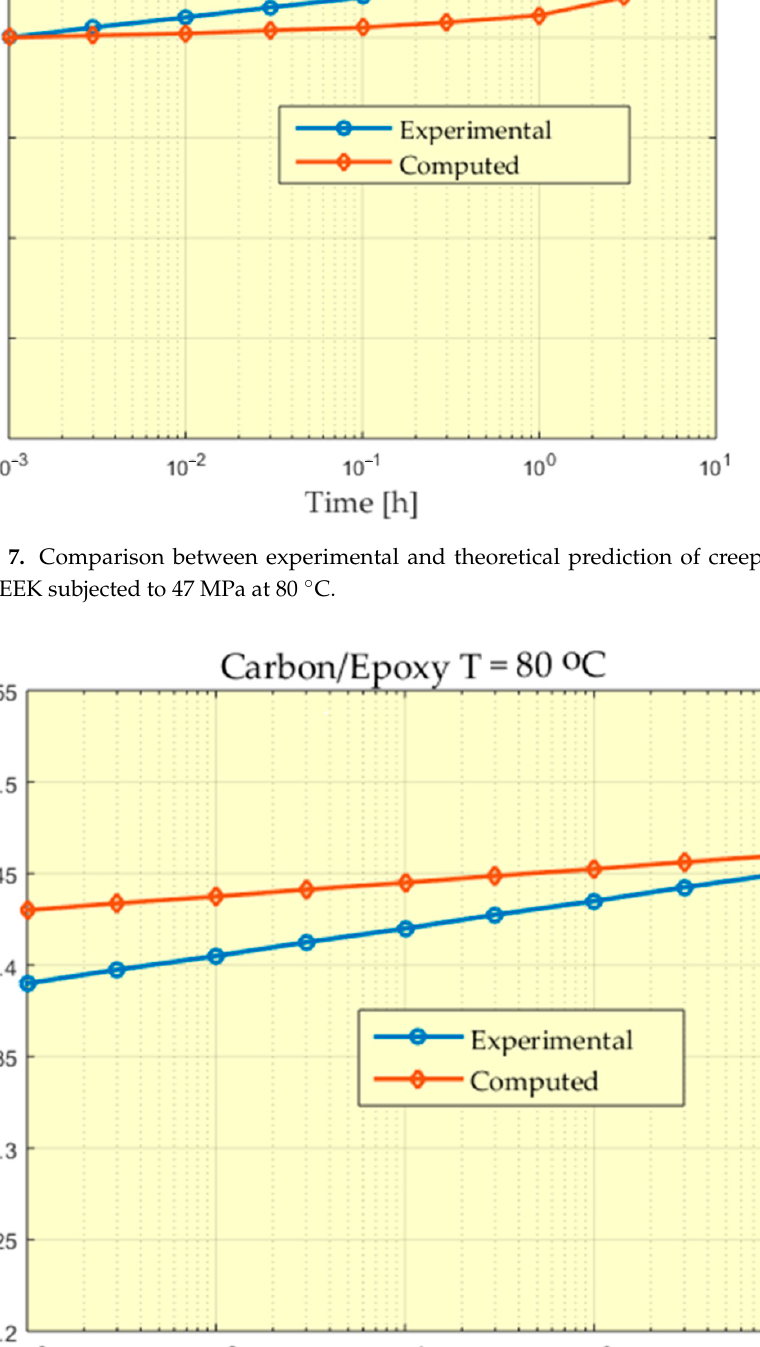
Figure 8. Comparison between experimental and theoretical prediction of creep strain for Car- bon/Epoxy subjected to 30 MPa at 80 ◦